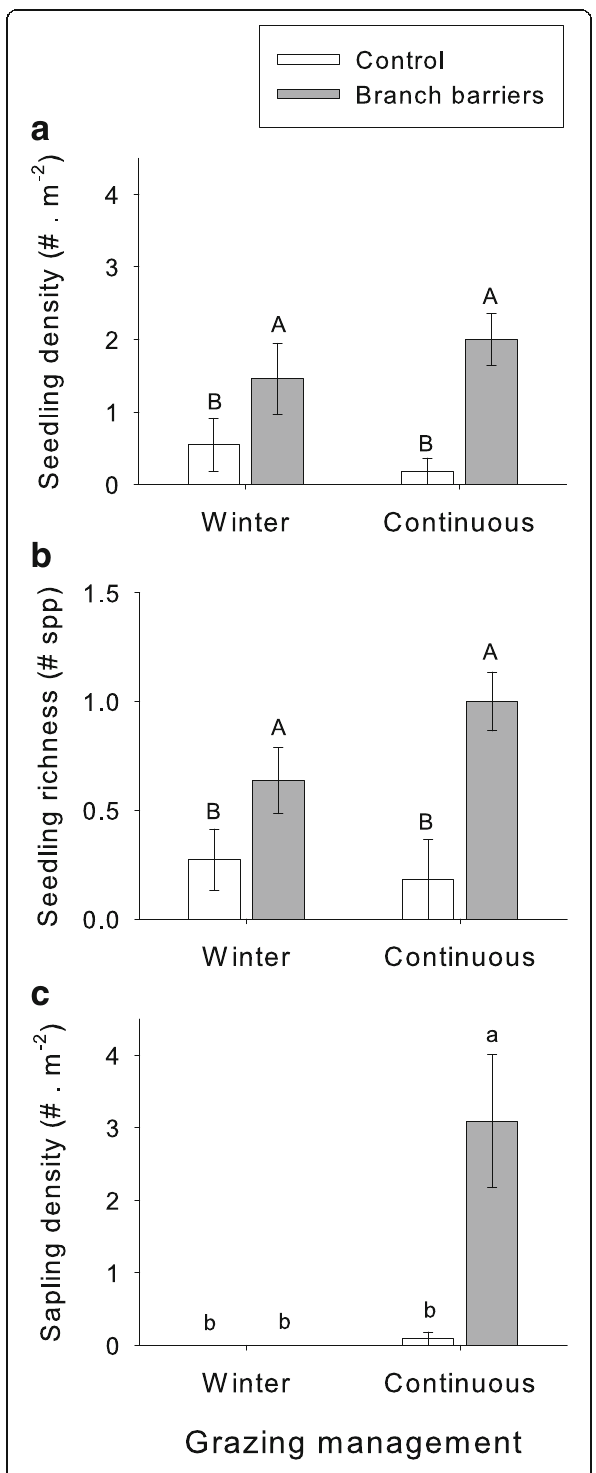
Fig. 4 Mean (± standard deviation, SE) of the density of seedlings ( a ) and saplings ( b ), and richness of seedlings of woody species found at microsite level in water run-off paths with and without branch barriers under different grazing managements: winter (a 1-ha temporary enclosure in which grazing was excluded until winter season, when it was grazed with a stocking rate adjusted to annual forage availability), and continuous (a 1-ha paddock that remained open to grazing throughout the year with a stocking rate of 0.16 AU ha − 1 ). Different lowercase letter showed significant differences for grazing management × branch barriers interaction ( ɒ = 0.05). Different uppercase letters indicated significant differences between levels of one factor ( ɒ =